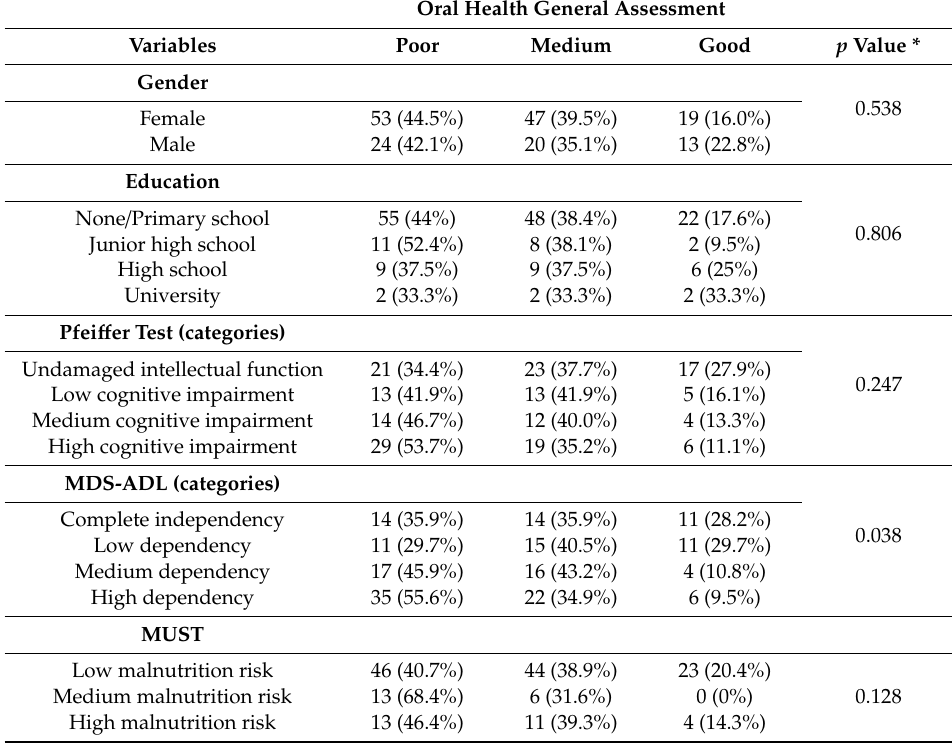
Table 2. The distribution of the enrolled subjects for the oral health general assessment and the other collected data in a study of oral health in nursing homes in Florence, Italy, October 2017–October 2018 ( n = 176).